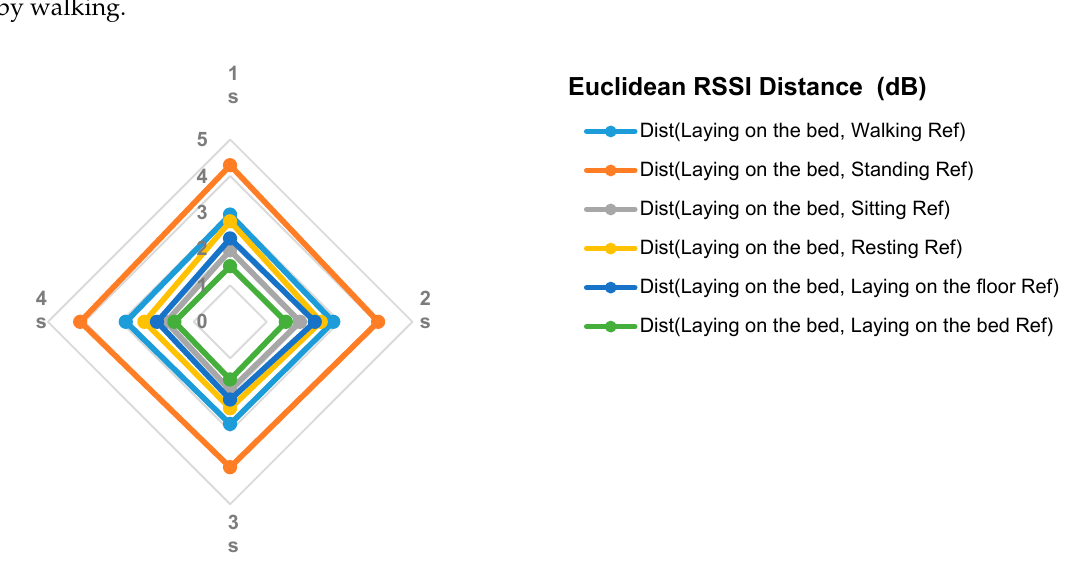
Figure 7. System performance for laying on the floor position over a stipulated timeframe.